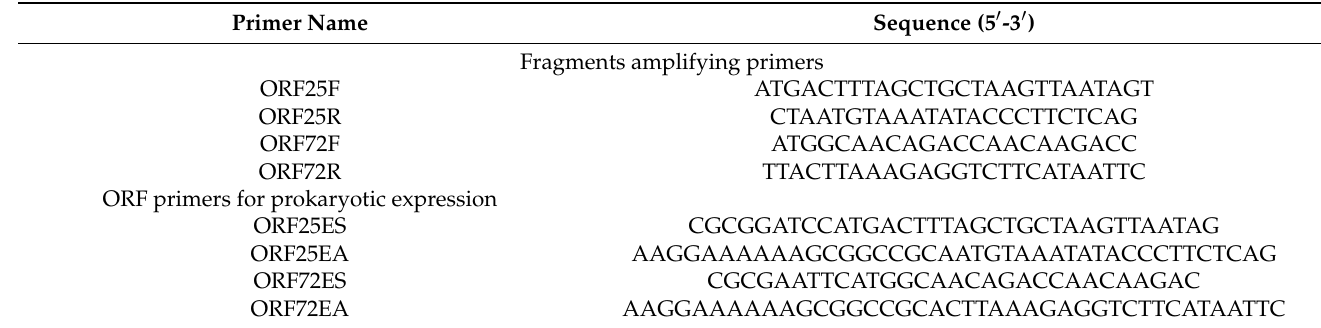
Table 1. Primers used in this